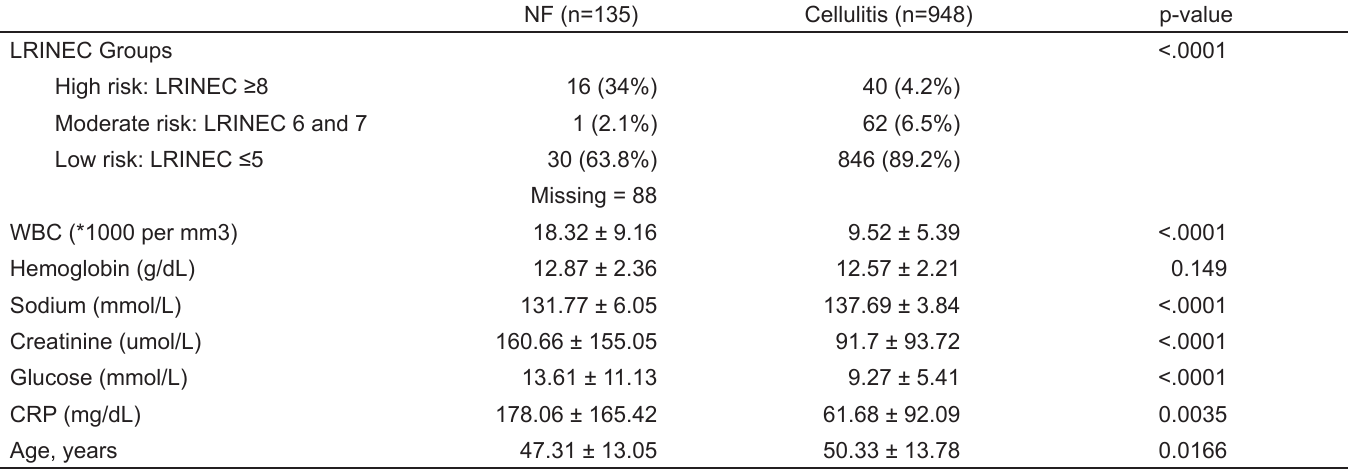
Table 1. Laboratory risk indicator for necrotizing fasciitis (LRINEC) score for necrotizing fasciitis and